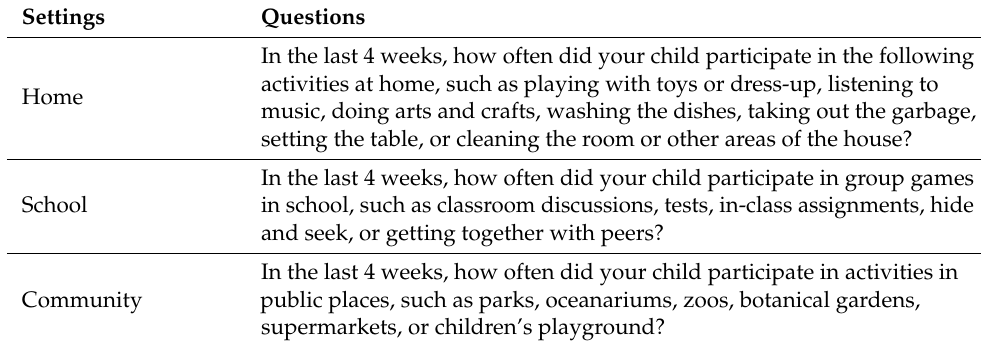
Table 1. Participation settings and corresponding